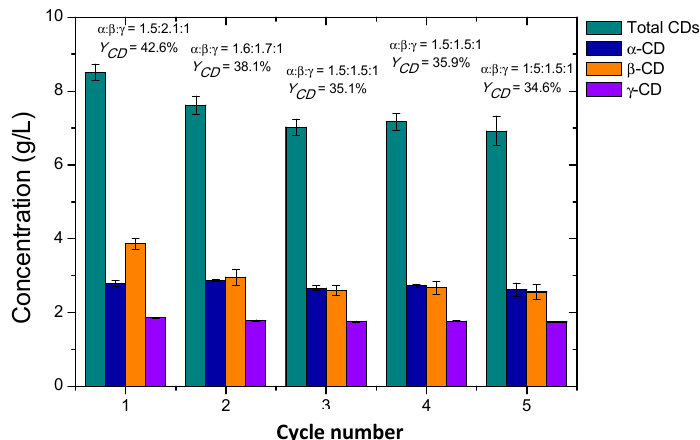
Figure 9. Reusability of CGTase CLEAs in cyclodextrin production at 50 ◦ C and pH 6.0, using an enzyme load of 5.0 U/g starch and 2.0% ( w / v ) pre-hydrolyzed starch (DE = 1.43) as substrate. The notes at the top of the columns represent the mass ratios of CDs ( α / β / γ ) produced and the starch-to-CD yields in each batch. Each cycle takes 3